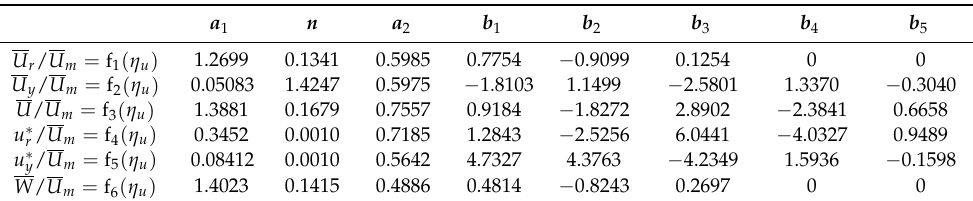
Table 1. The values of coefficients in Equation (7) describing the profiles of air velocity distribution parameters.